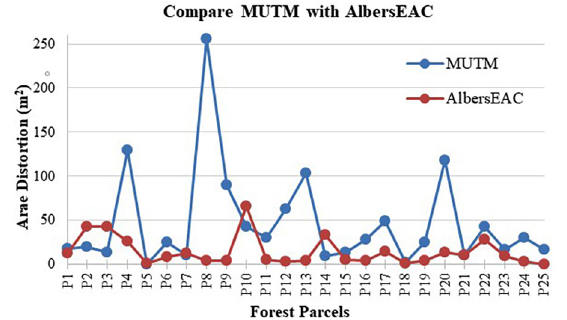
Figure 5. Comparison of the MUTM with the AlbersEAC in terms of area